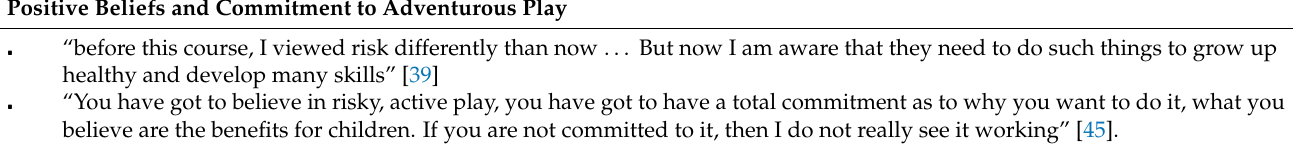
Table 7. Synthesised finding 5: Perceptions of adventurous